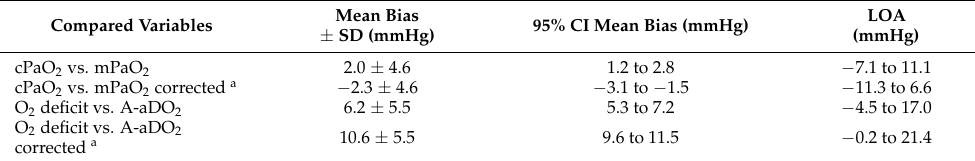
Table 2. Agreement among parameters derived from the AGM100 and EPOC